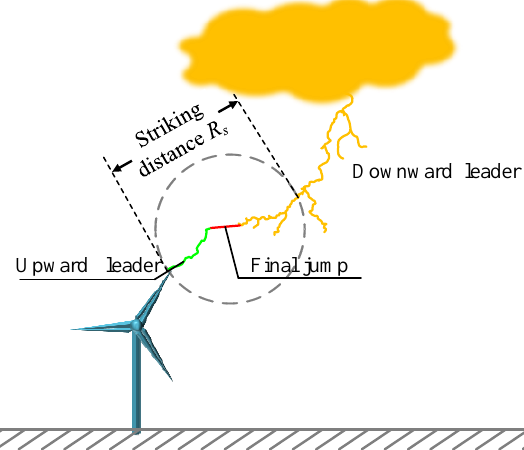
Figure 4. Schematic diagram of the striking distance.